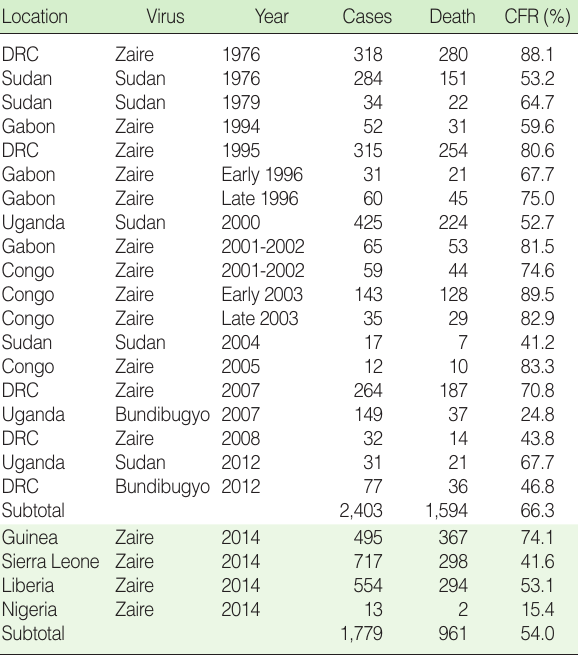
Table 1. Confirmed outbreaks of Ebola virus disease (excluding isolated cases) Location Virus Year Cases Death CFR